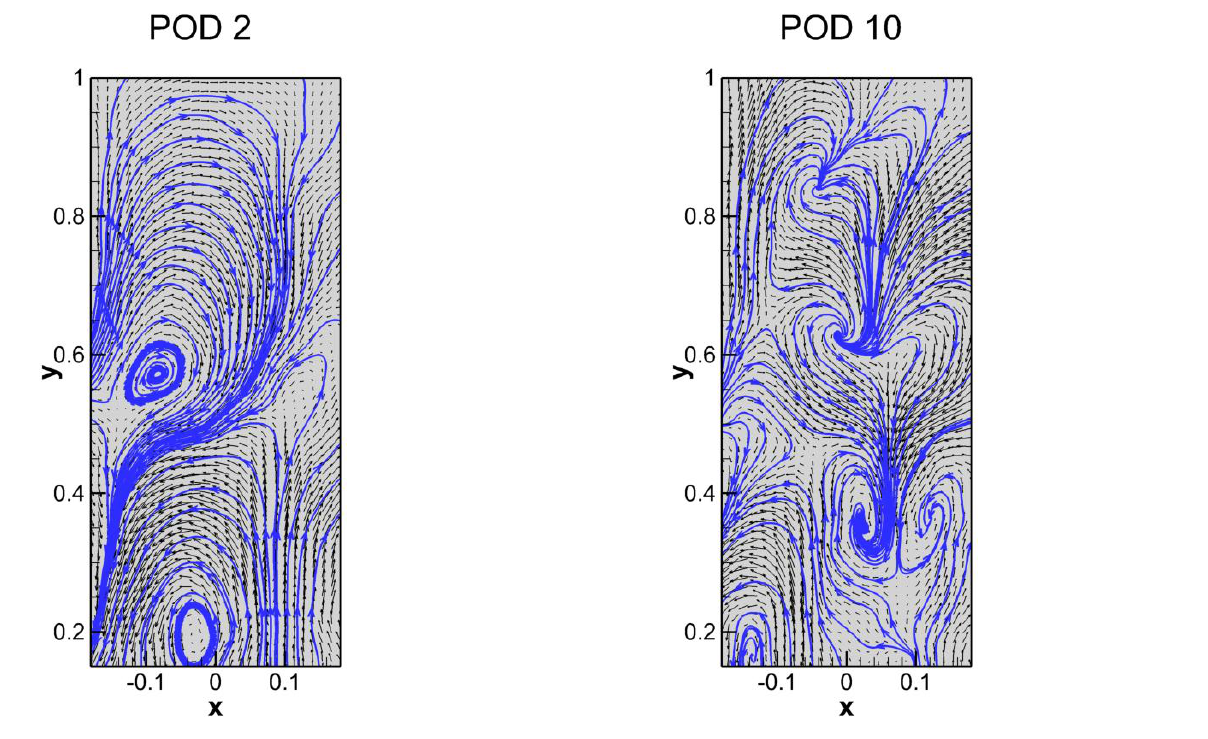
Fig. 13. Velocity POD mode No. 10, 1.4%